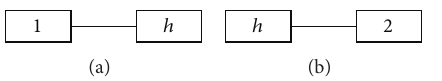
Figure 2: The proposed roughly reliability model diagram (a) and diagram (b) of the hybrid system in [5].